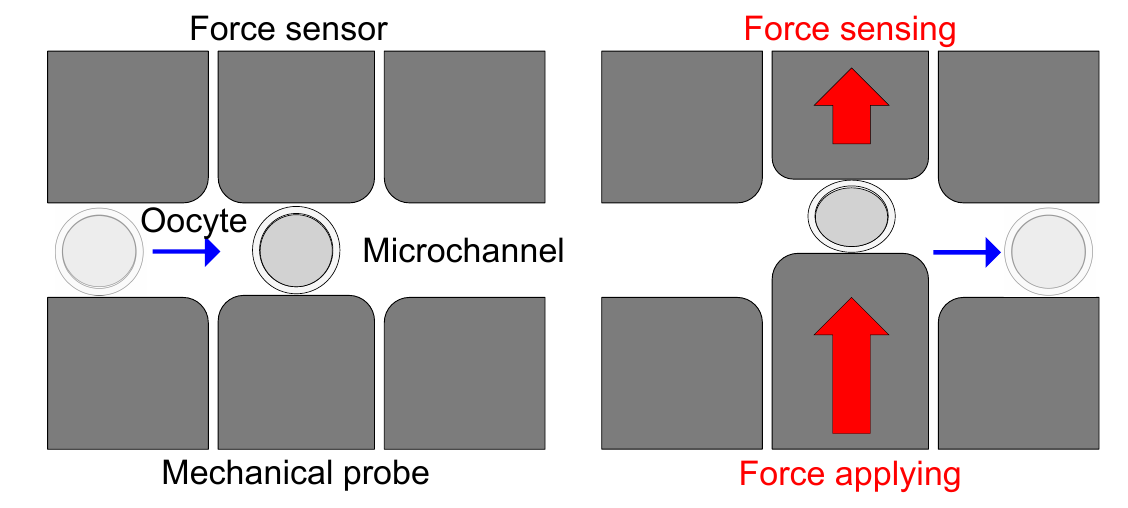
Figure 1. On-chip measurement of mechanical characteristics of